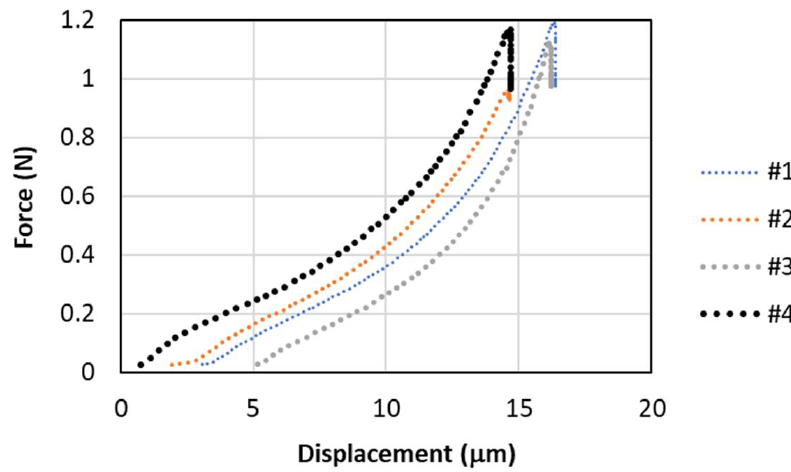
Table 2. Examples of fitting parameters and the estimated ultimate tensile strength (UTS) for particles #1–4, as obtained from the two different fitting procedures.